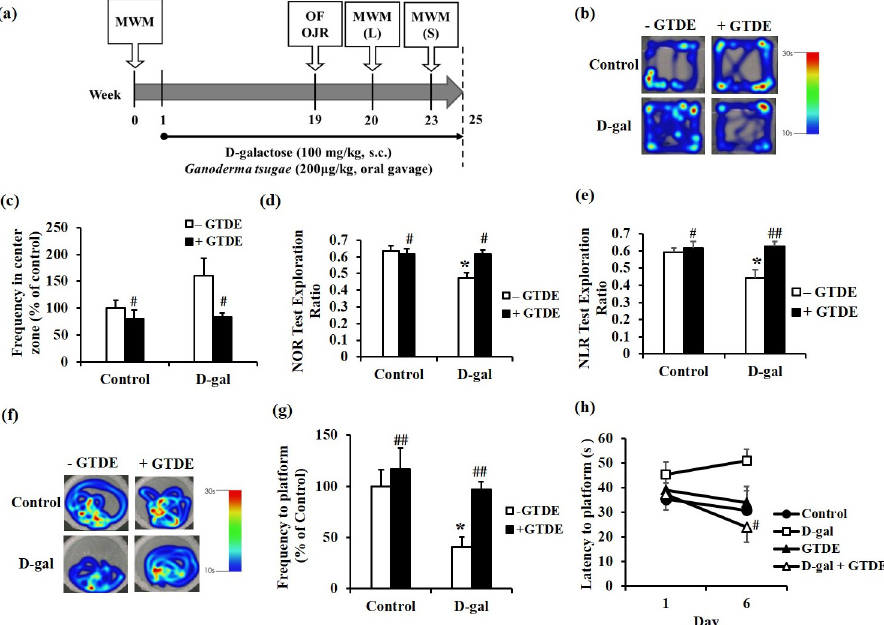
Fig 1. GTDE restored recognition memory against d-gal induced aging. The rats received daily drug administrations based on group assignments. D-gal was administered by subcutaneous injection at a dose of 100 mg/ kg/day, and GTDE was administered orally at a dose of 200 μ g/kg/day. Rats in the control group received equivalent volumes of the solvent. At 18 weeks after the commencement of drug administration, the rats were subjected to the open-field test ((b), (c)), object recognition test ((d), (e)), and Morris water maze test ((f) to (h)). (a) The detailed experimental schedule. (b) The heat map for the open-field test, with red denoting the maximum duration of stay of 30 s and blue denoting the minimum duration of 10 s. (c) The quantified frequencies at which the rats reached the central zone. (d) Results of the NOR test. (e) Results of the NLR test. (f) Heat map for the Morris water maze test, with red denoting the maximum duration of stay of 30 s and blue denoting the minimum duration of 10 s. (g) Quantified frequencies of platform exploration during the long-term memory test. (h) Results of the working memory test. Intergroup differences were compared using one-way ANOVA followed by the Tukey’s multiple comparisons test. Statistically significant differences based on comparisons with the control group are denoted by � P < 0.05, �� P < 0.01, ��� P < 0.001; statistically significant differences based on comparisons with the D-gal group are denoted by # P < 0.05, ## P < 0.01, ### P < 0.001. n = 7 per